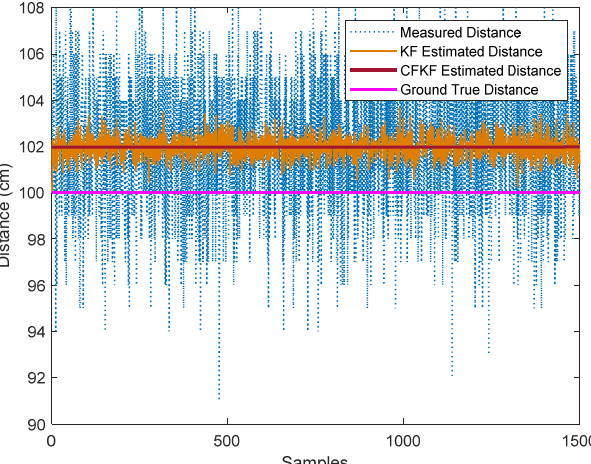
Figure 7. Error modelling calibration result comparison with different algorithms (UWB anchor 1).